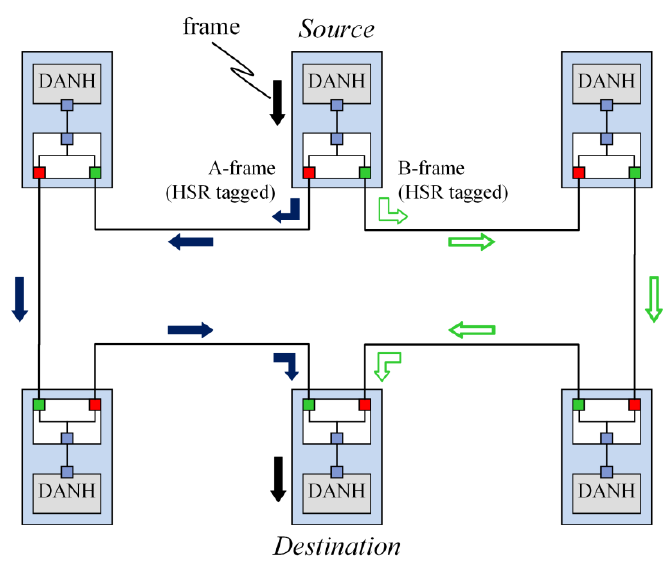
Figure 1. HSR example of single-ring topology for unicast